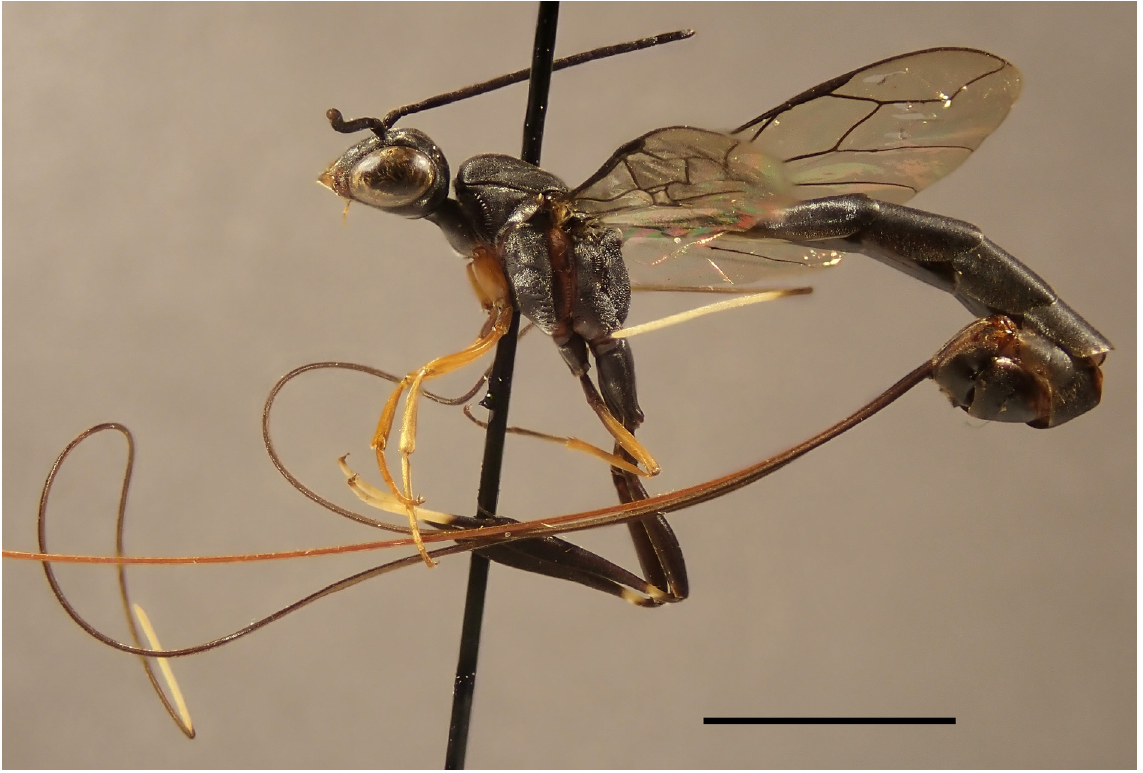
Fig. 9. Gasteruption maquis Jennings, Krogmann & Parslow, 2015 (MNHN). Lateral habitus. Scale bar = 5.0